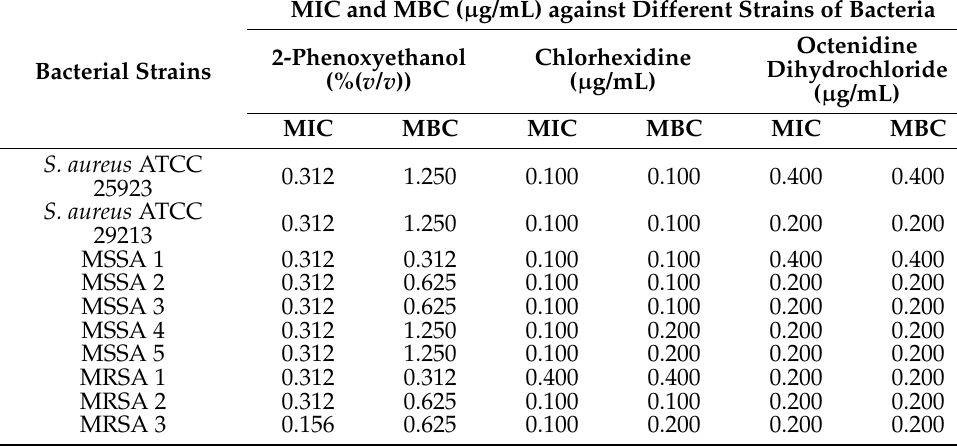
Table 2. Antimicrobial activity of antiseptics against different strains of S. aureus. MIC and MBC ( µ g/mL) against Different Strains of Bacteria 2-Phenoxyethanol Bacterial Strains (%( v/v